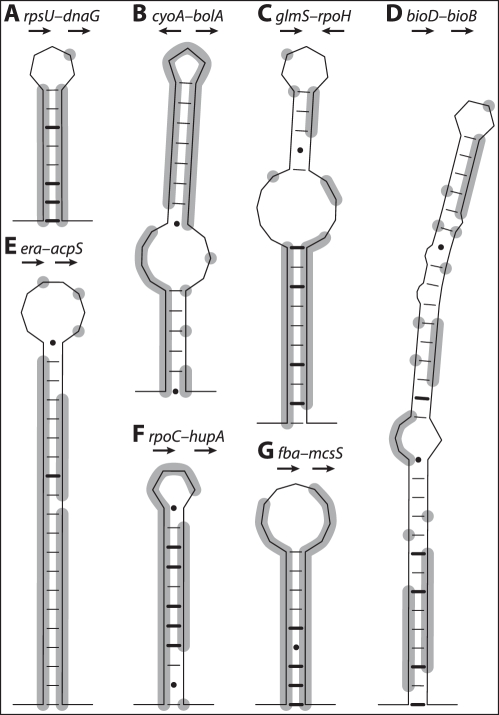
Structural predictions for IGSs with conserved elements across Buchnera-Ap, Ak, Ua, and Sg.Genes flanking each IGS and their relative orientation are shown. Positions identical in all four Buchnera genomes are highlighted in grey. Bonds between cytosine-guanine (C–G) pairs are shown as bold lines, adenine-thymine (A–T) pairs as thin lines, and guanine-thymine (G–T) pairs shown as dots (•).